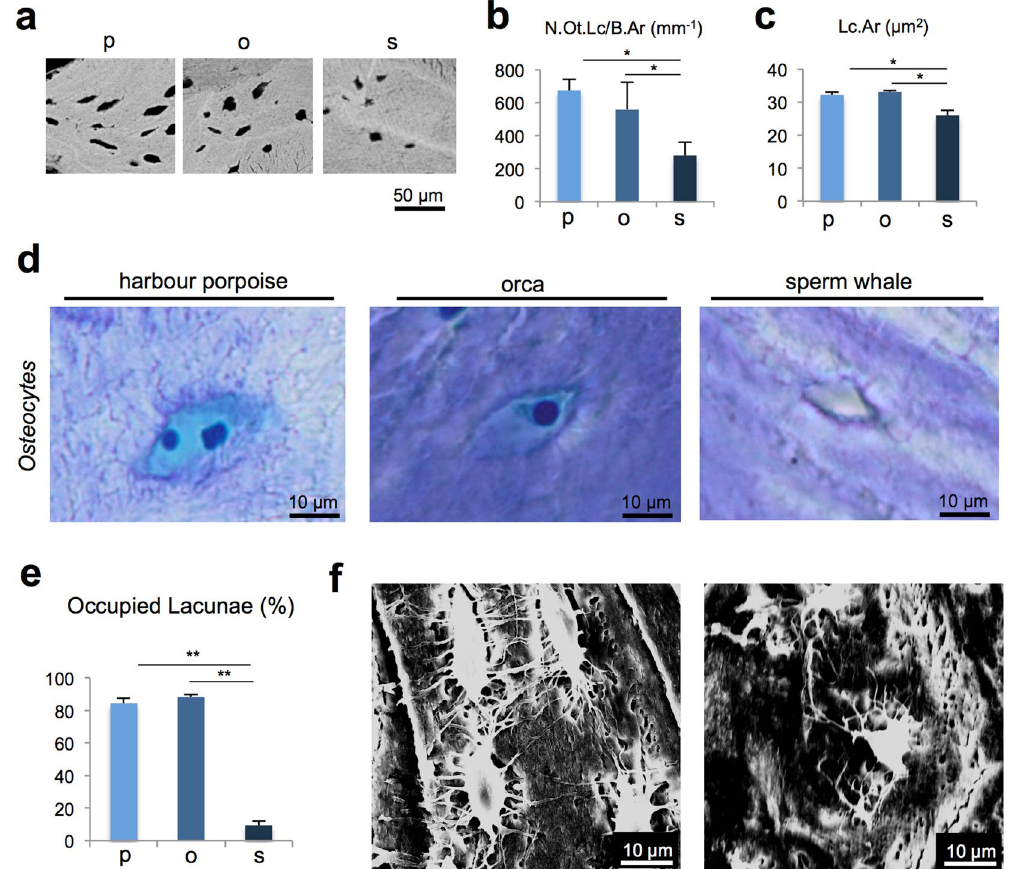
Figure 5. Osteocyte characteristics. ( a ) Representative images obtained using BSEM show the differences in lacunar number and size. ( b ) The number of osteocyte lacunae per bone area (N.Ot.Lc/B.Ar) was significantly lower in the sperm whales than that in the other whale species. ( c ) Osteocyte lacunar area (Lc.Ar) was smaller in the sperm whales. * P < 0.05. ( d ) Toluidine blue-stained sections of undecalcified bone specimens revealed that the harbour porpoise had several osteocytes with 2 cell nuclei, the orca had typically shaped osteocytes and the sperm whale showed only small and empty lacunae; 400x magnification. ( e ) Percentage of occupied (viable) lacunae was significantly decreased in the sperm whales. ** P < 0.001. ( f ) Images of the osteocyte lacunar connections performed via acid etching of the acrylate embedded specimens followed by scanning electron microscopy (SEM); the images show a well-developed lacunocanalicular system in the orca (left image), whereas poor connections via canaliculi are observed among osteocytes in the sperm whale bone (right